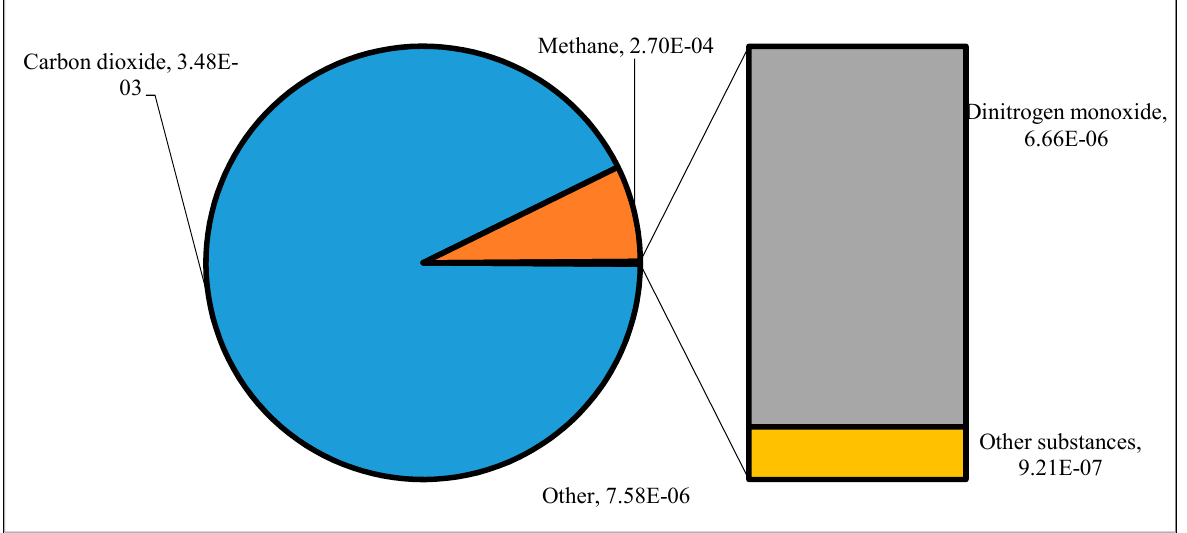
Figure 7. The relevant airborne (substance) emissions produced in kg CO 2 eq per 100 year period for the whole process of the SWRO system.